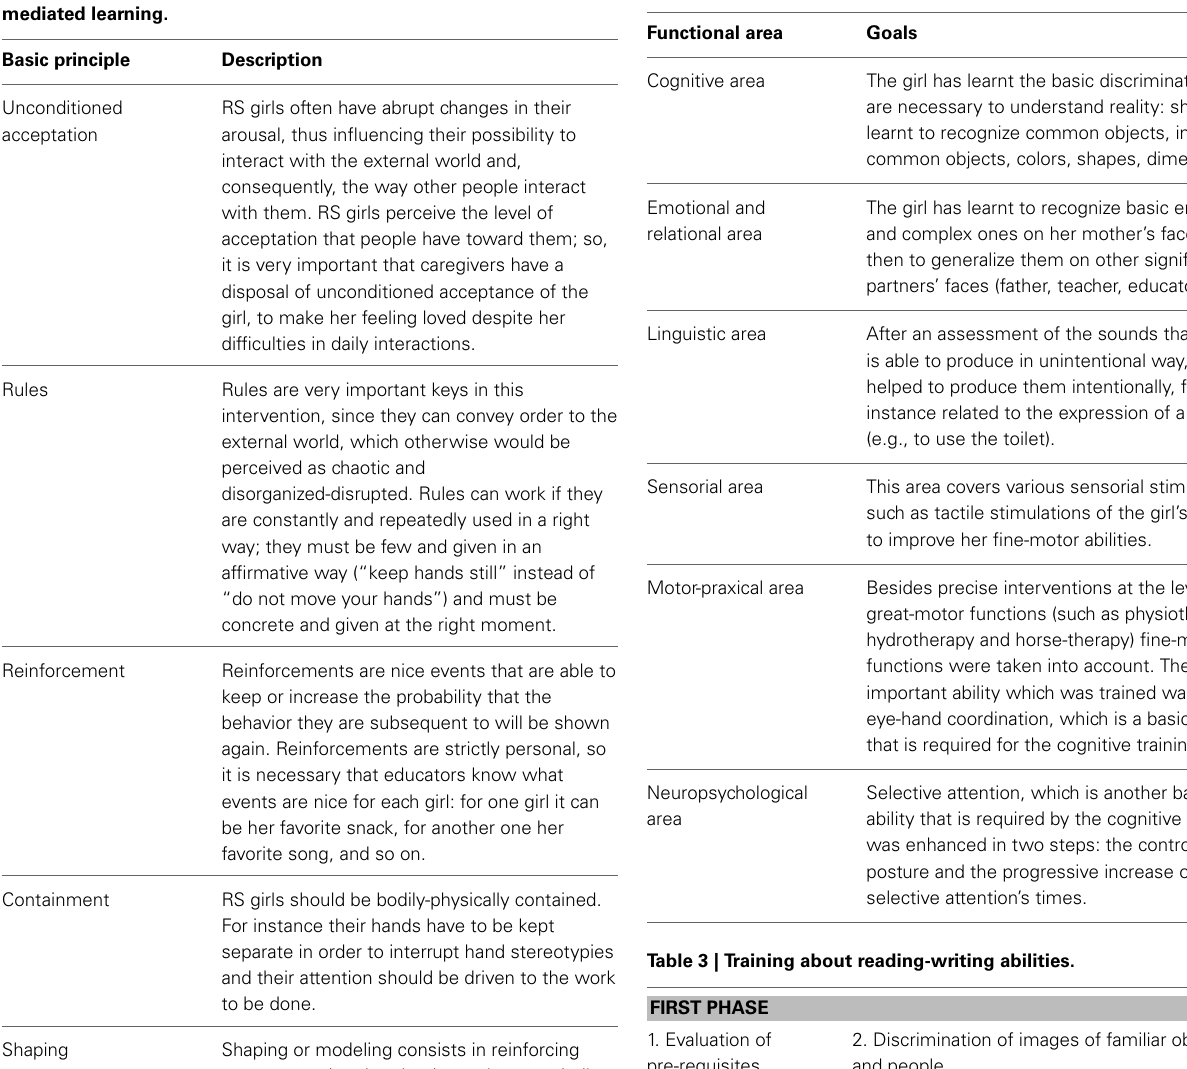
Table 2 | Training about basic concepts.